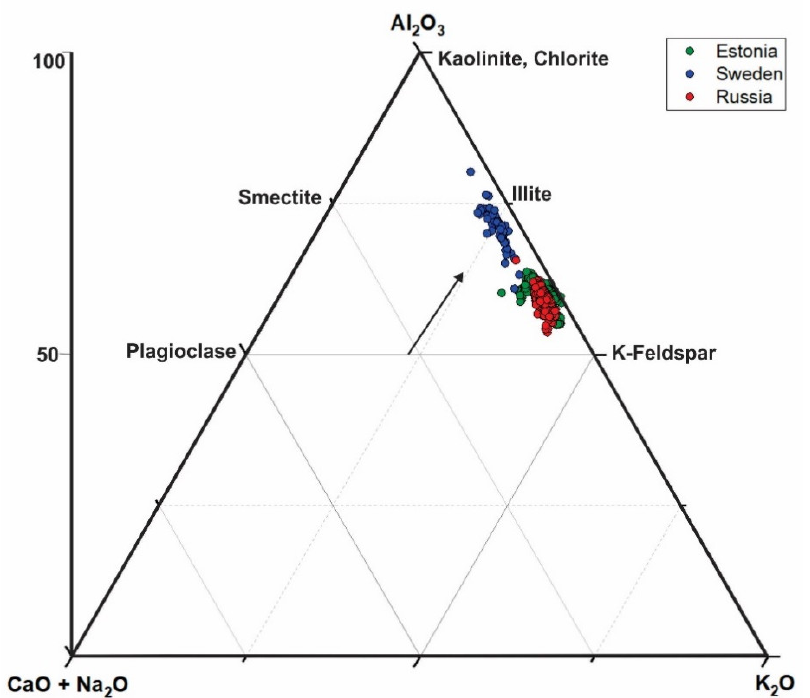
Figure 6. Ternary diagram for the estimation of the degree of chemical weathering of the black shales, based on molecular proportions of Al 2 O 3 , CaO, Na 2 O, and K 2 O [61]. Vertical scale represents the Chemical Index of Alteration.